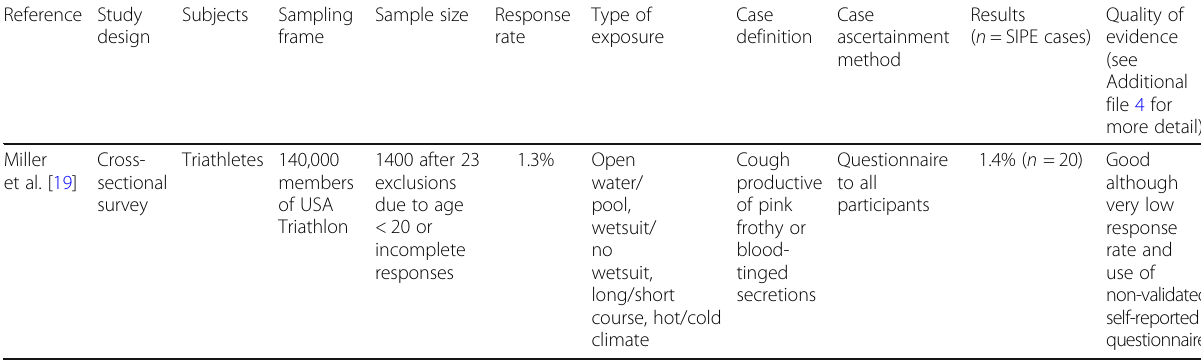
Table 2 Prevalence of having experienced SIPE Reference Study